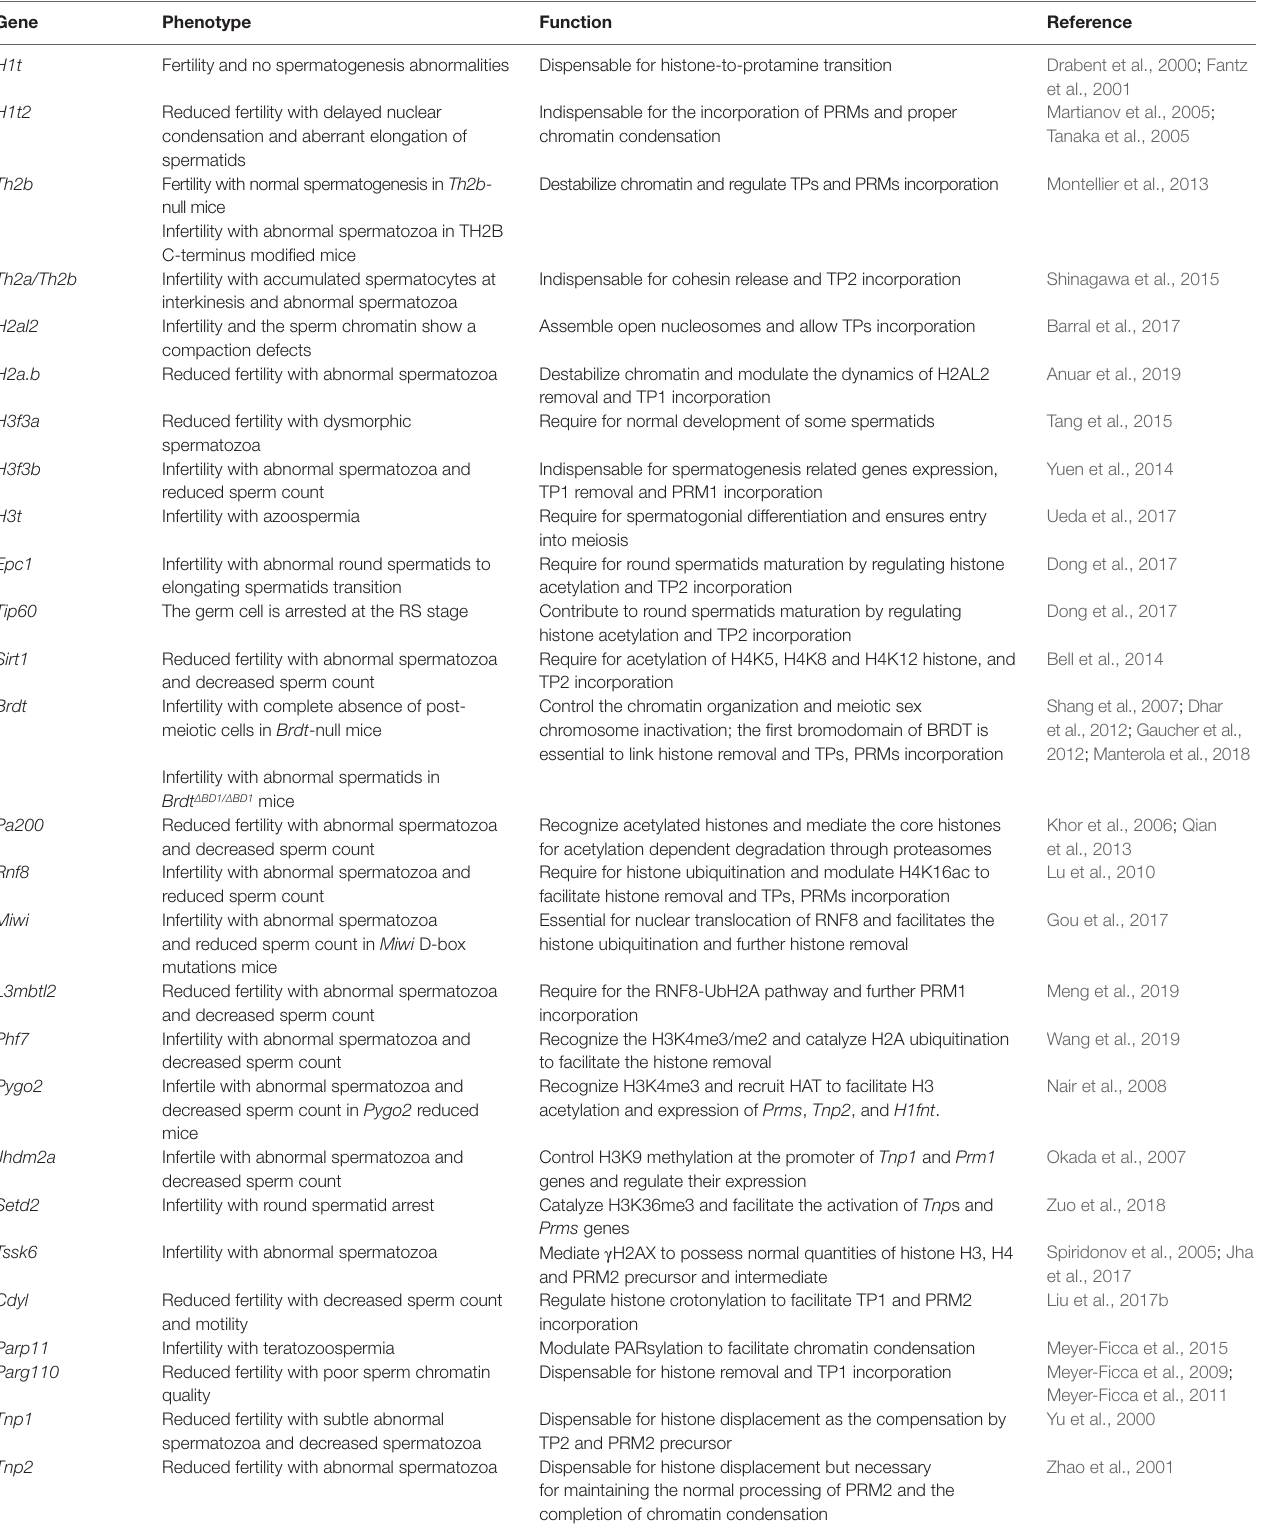
TABLE 2 | Mouse models related with the histone-to-protamine